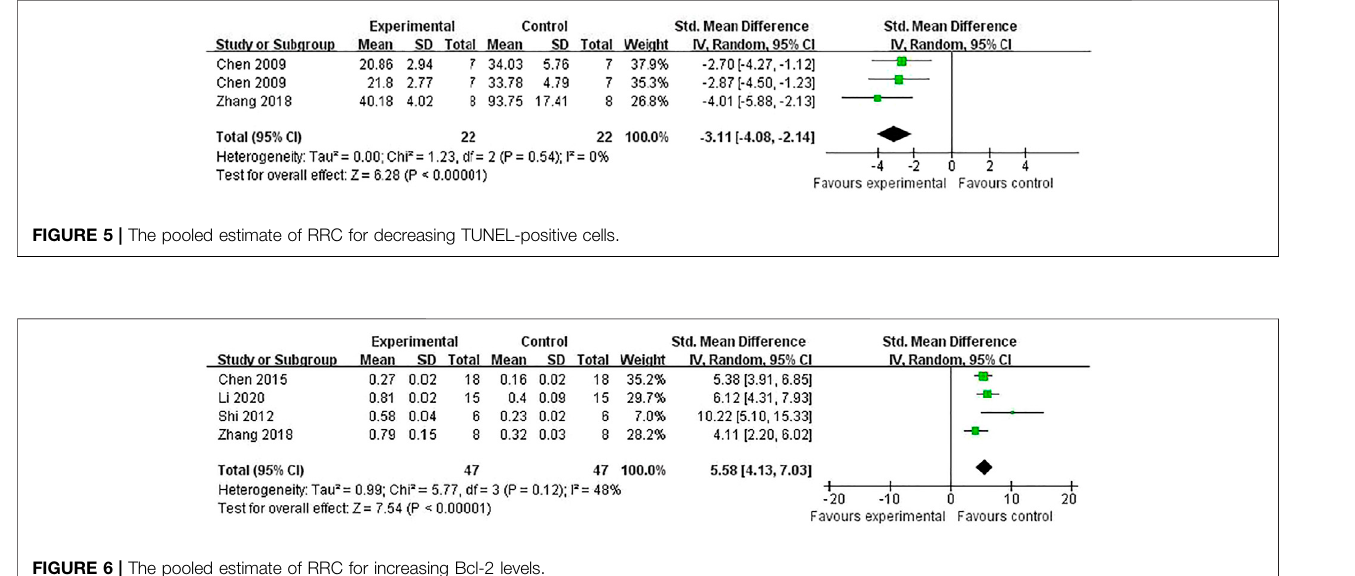
Frontiers in Pharmacology |